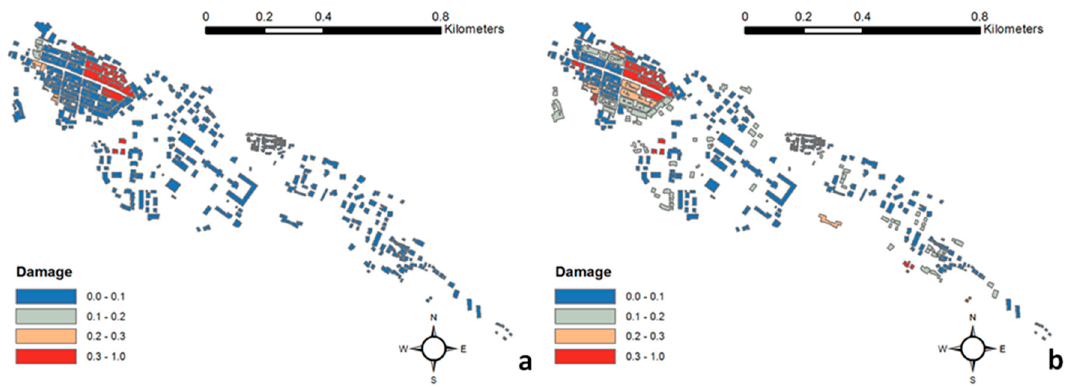
Figure 7. Amatrice CR maps obtained analyzing post 24 August 2016 remote sensing data: ( a ) NN with only optical features as input; ( b ) NN using both optical and SAR features.